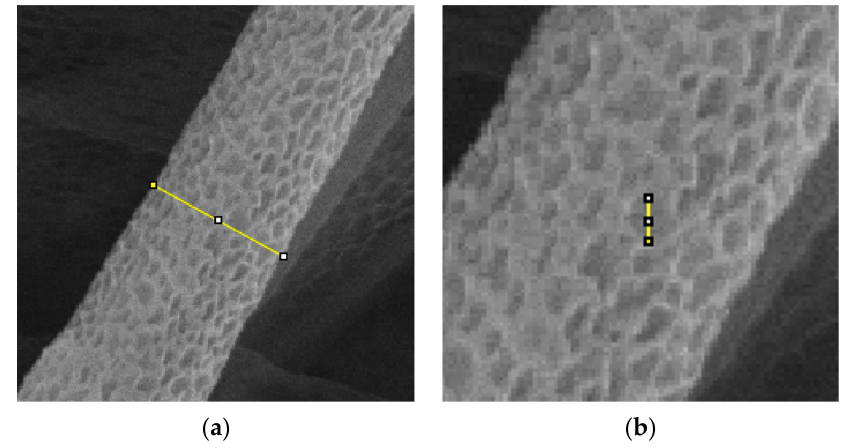
Figure 2. Measurement for ( a ) microtube diameter and ( b ) pore size.